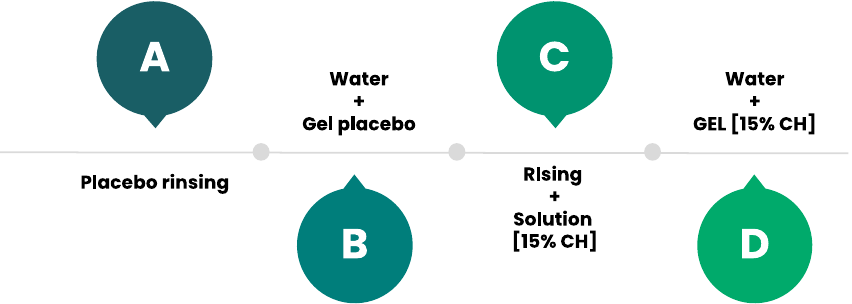
Figure 5. Intervention groups. A = Group A; B = Group B; C = Group C; D = Group D.